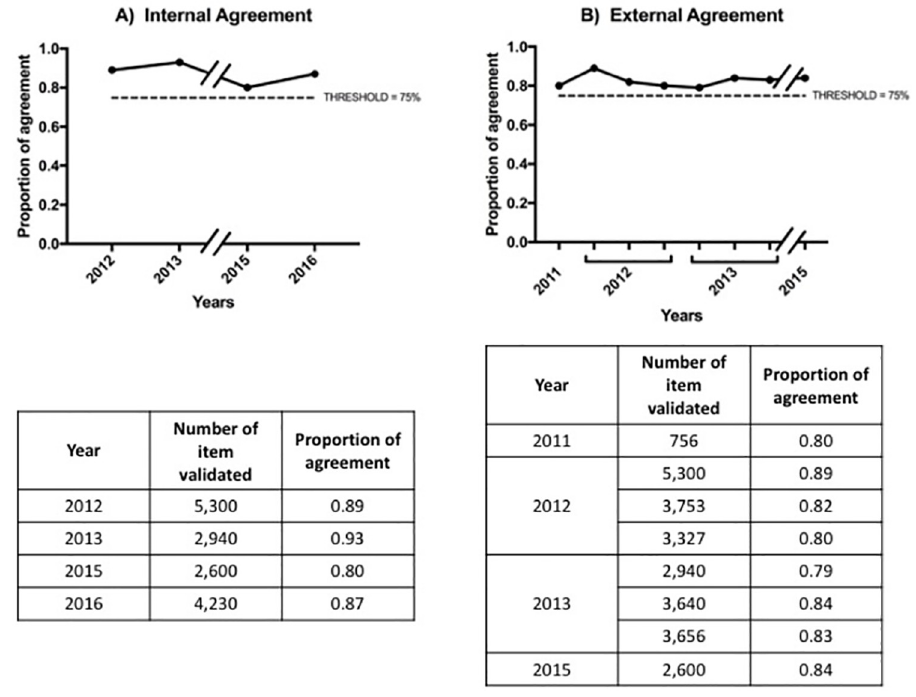
Fig 4. Proportion of internal (A) and external (B) agreement in the data validation process. Internal agreement was performed once a year from 2012 to 2016, with the exception of 2014. External agreement was performed from 2011 to 2015 after the major changes of items, major changes of CR and in case of new professionals involved. The two proportions of agreement were above the threshold (75%) decided by the Quality Unit as satisfactory. Table legends show, for each year, the proportion of agreement and the number of items validated by the professionals of the Quality Unit and the peer-reviewers from each